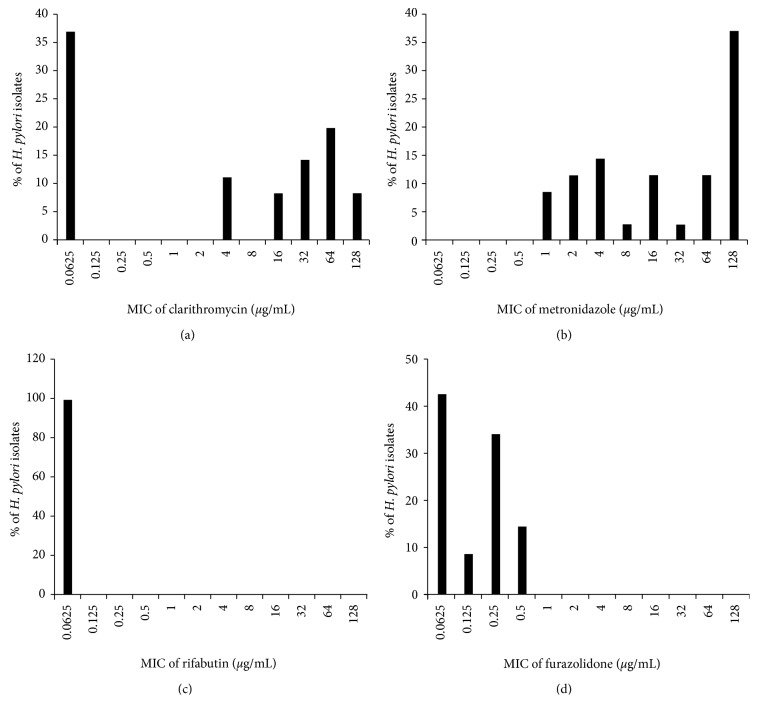
MIC distribution of (a) clarithromycin, (b) metronidazole, (c) rifabutin, and (d) furazolidone for H. pylori. MIC, minimum inhibitory concentration.